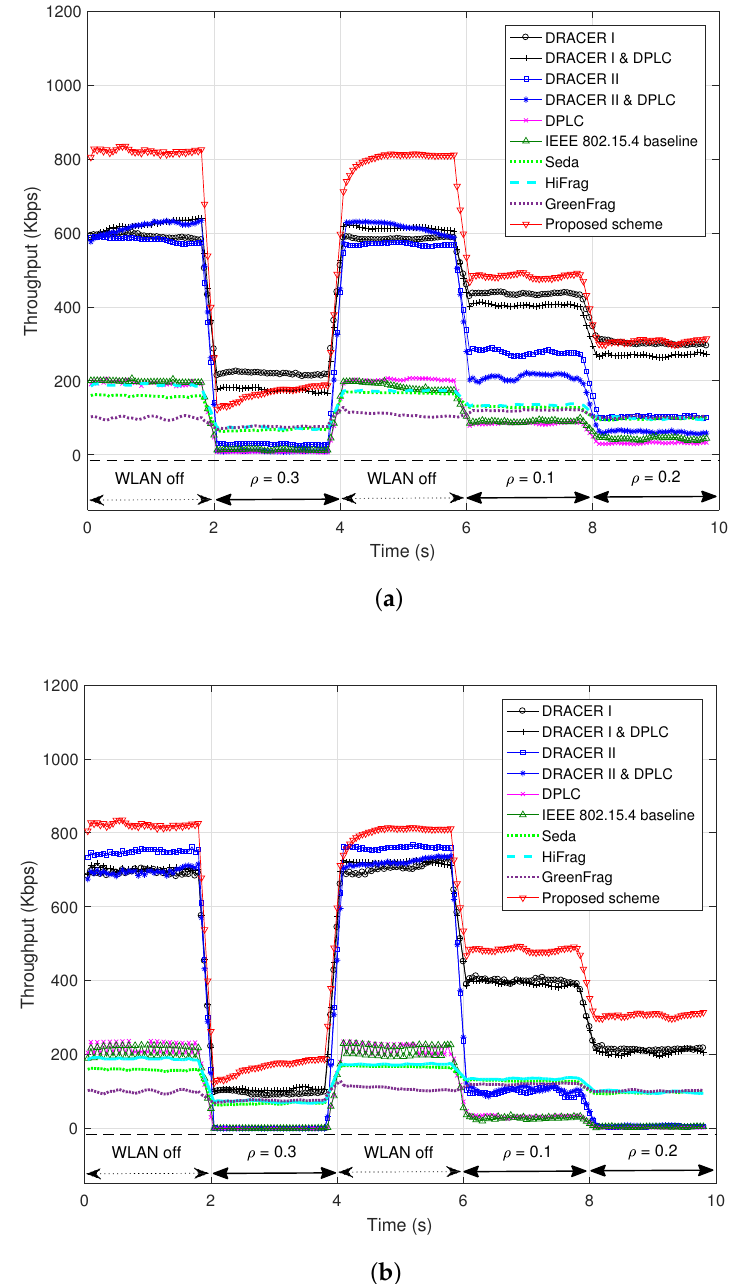
Figure 7. Throughput according to the change of interference. ( a ) When L = 300 bytes; ( b ) When L = 1000